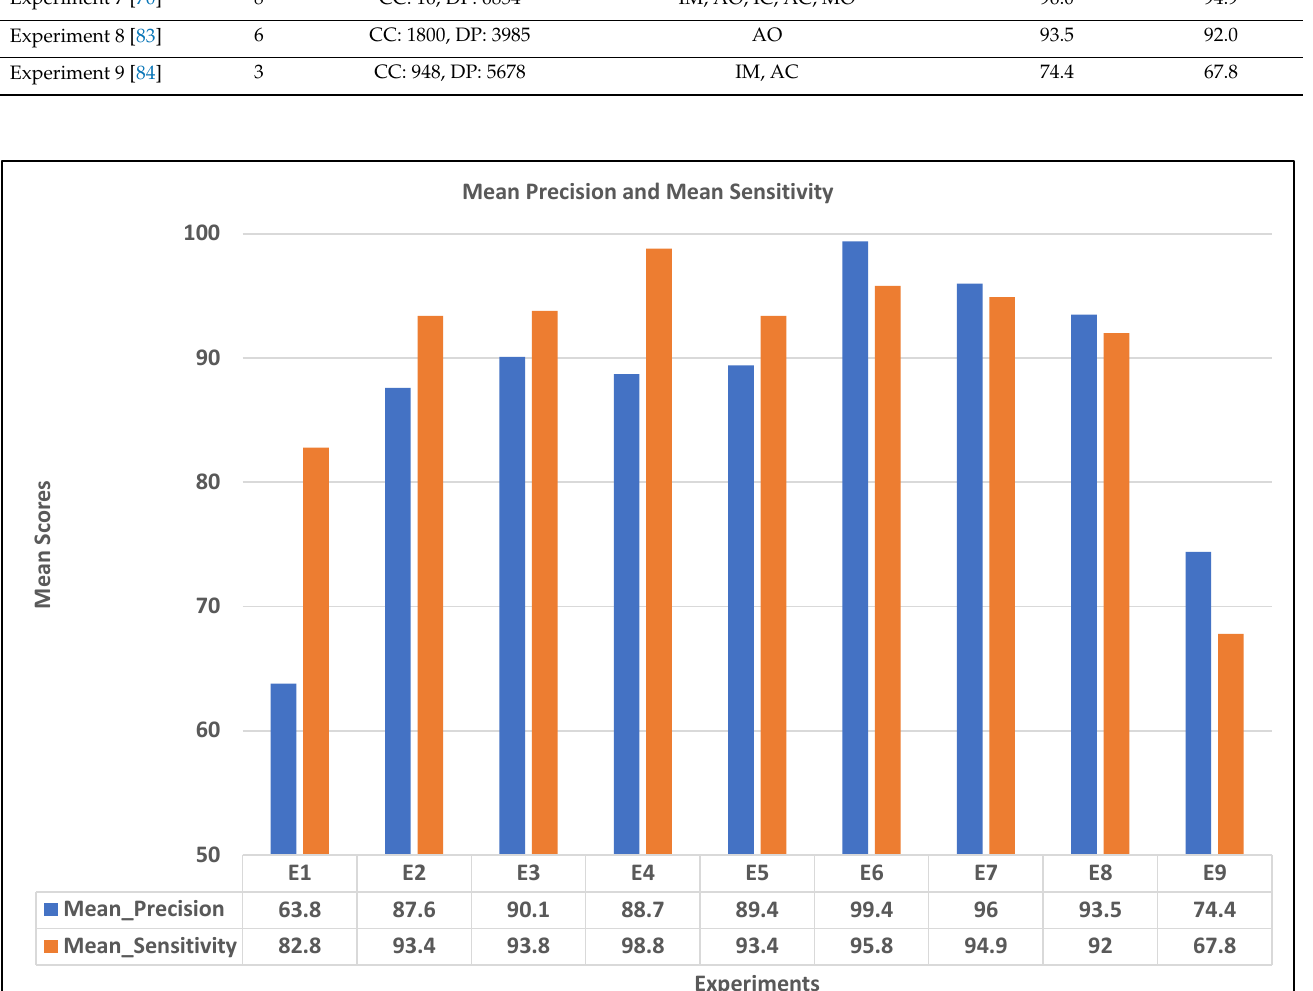
Figure 13. Mean precision and mean sensitivity values of all